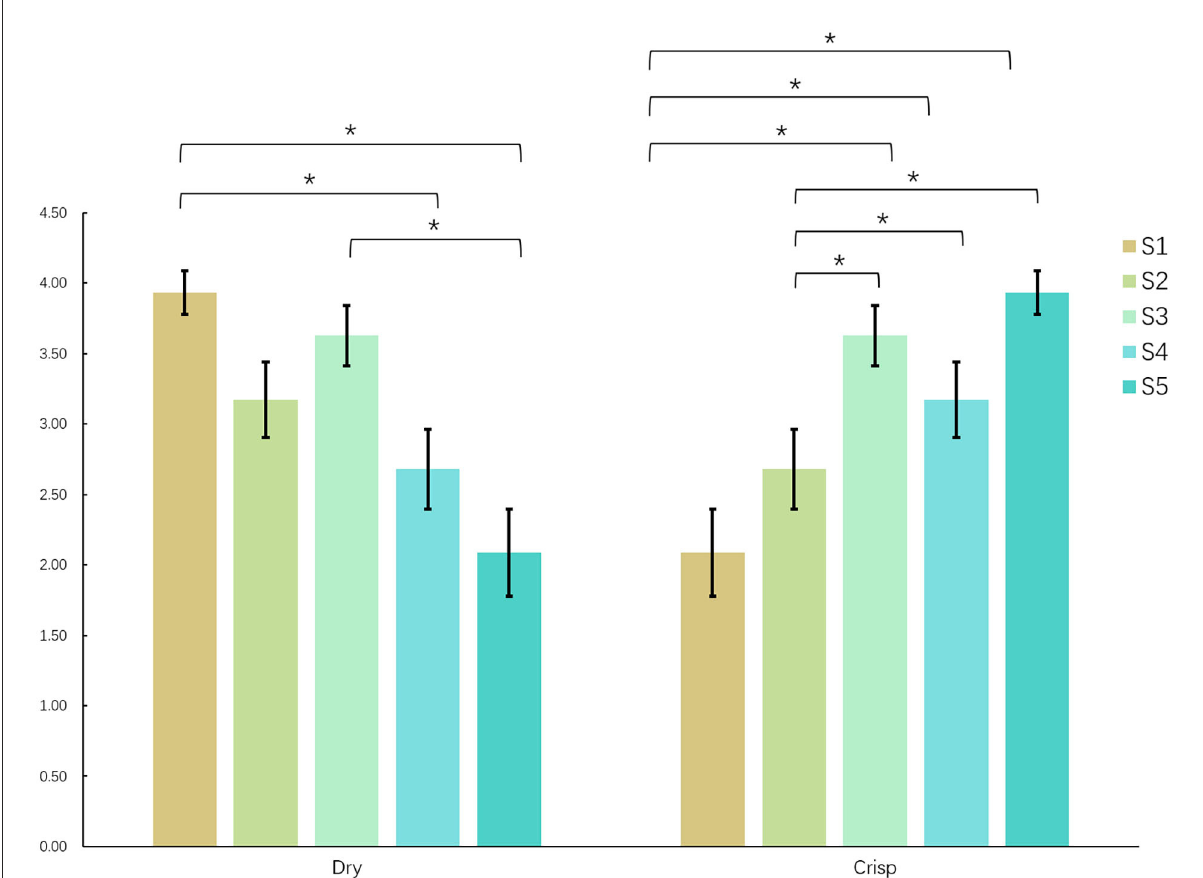
FIGURE6 Mean rating ( ± SE) of five stimuli at dry and crisp. Asterisks indicate statistical significance at p < 0.05 (*) (Games-Howell